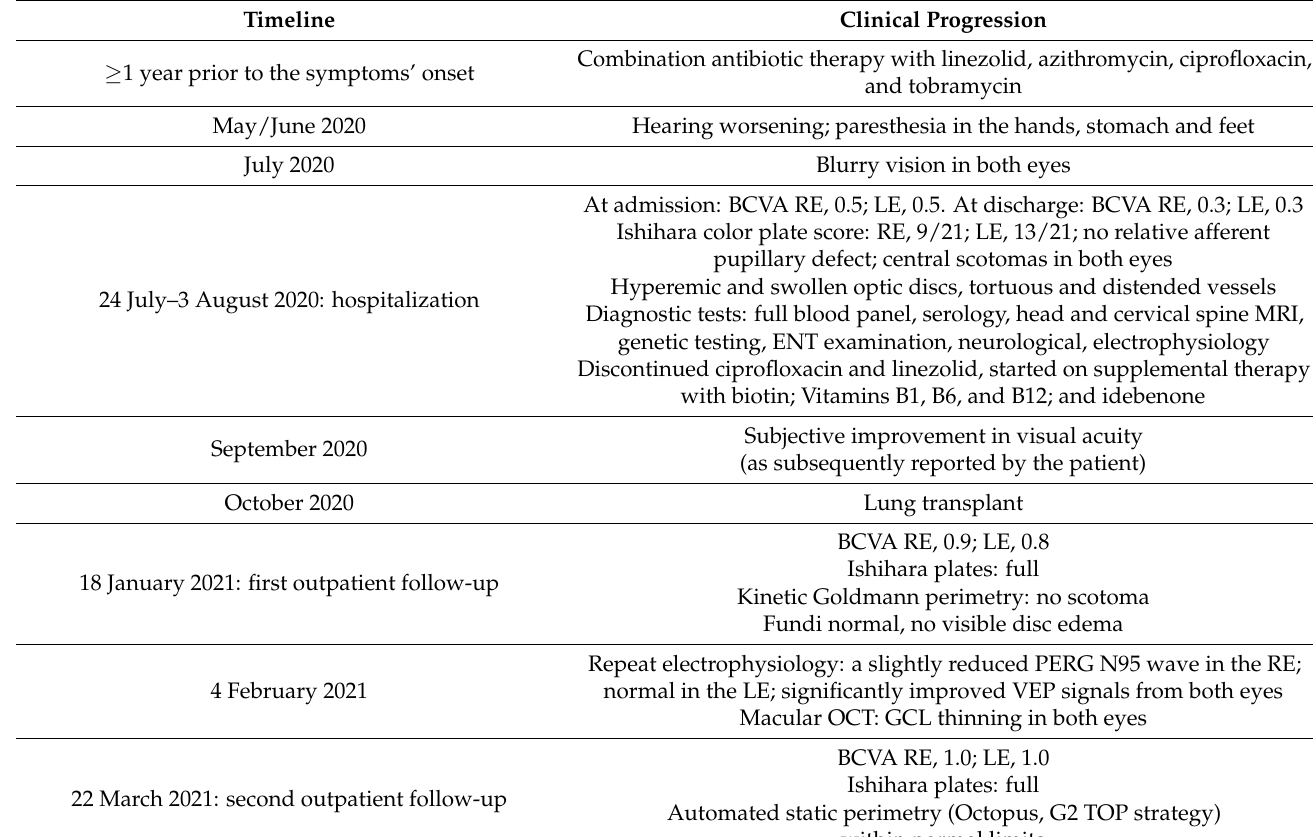
Table 1. Timeline of the clinical